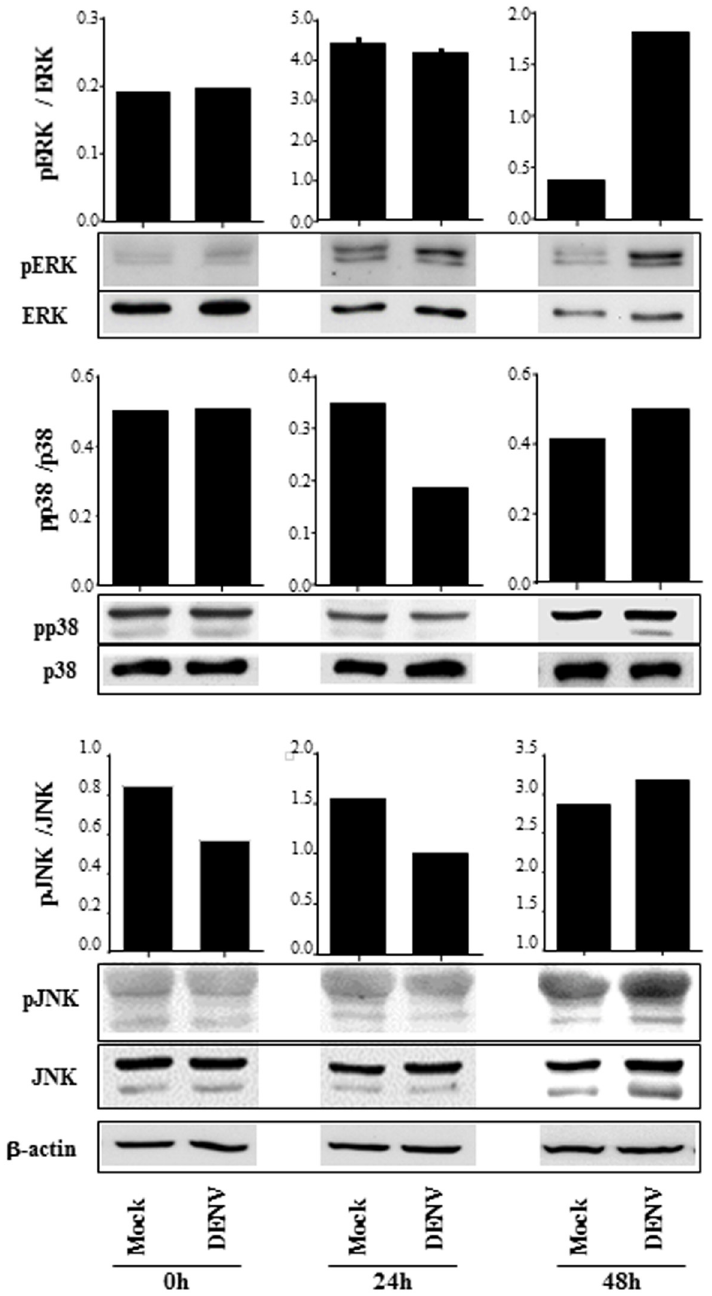
Fig 3. B cell infection by DENV promotes MAPK phosphorylation. B lymphocytes were mock-treated or cultured with DENV2 (MOI = 1). The cells were harvested after 2h, 24h or 48h p.i., and the expression of ERK, p38 and JNK MAPK were analyzed in the cell lysates by western blotting, using the indicated antibodies. The bars indicate the ratio between the analyzed phosphorylated protein and the corresponding non phosphorylated one; β actin staining were performed as a loading control and is shown in the bottom of the figure. Data are representative of three independent experiments.